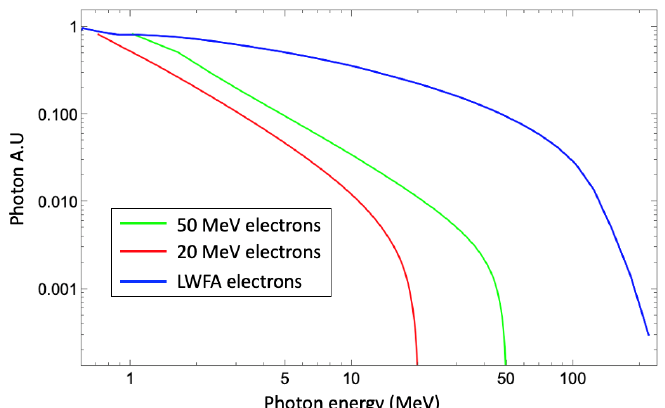
Figure 4. Photon energy spectrum resulting from injecting mono-energetic 20 MeV (red), 50 MeV (green) electrons and LWFA electrons (blue) at a center of a 10 cm lead sphere.